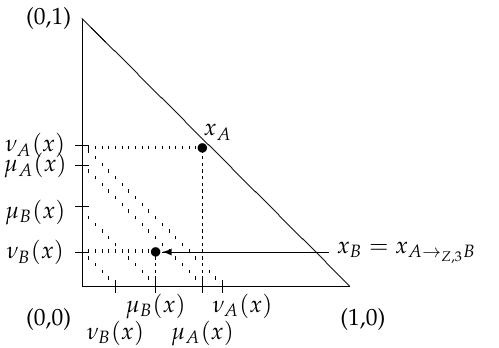
, x B and x – the third scenario B – the third scenario 49 A A B → Z ,3 B – the third scenario 49 → Z ,3 → Z ,3